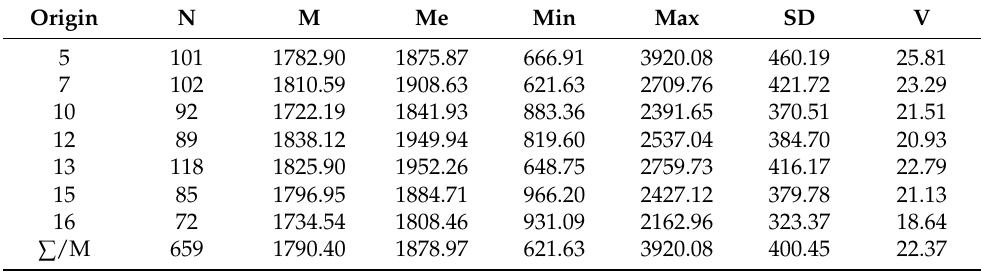
Table 7. Characteristics of JEg (km) of diverse genetic origins (N—Number of groups; M— Average; Me—Median; Min—Minimum; Max—Maximum; SD—Standard deviation; V—Coefficient of